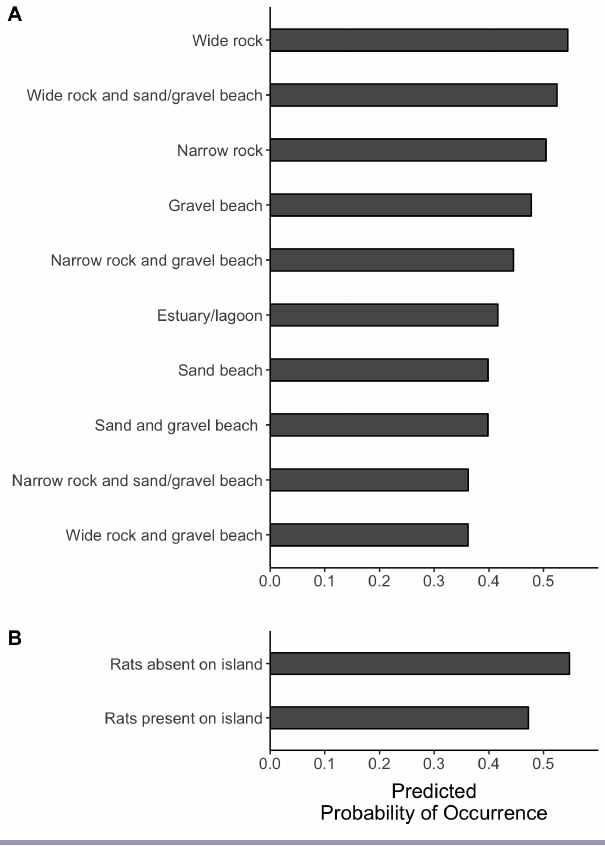
Fig. 3 . Partial dependence plots for categorical predictors retained in final model. Partial dependence plots show the effect of a given predictor on the response, with all other predictors held at their